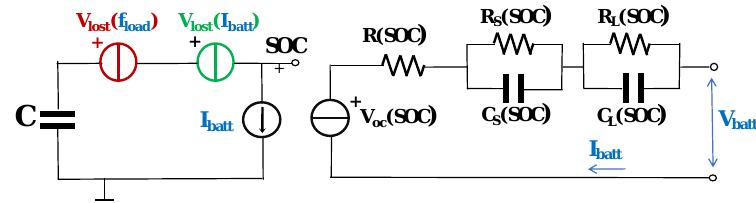
Figure 3. Adopted circuit-equivalent model for the battery